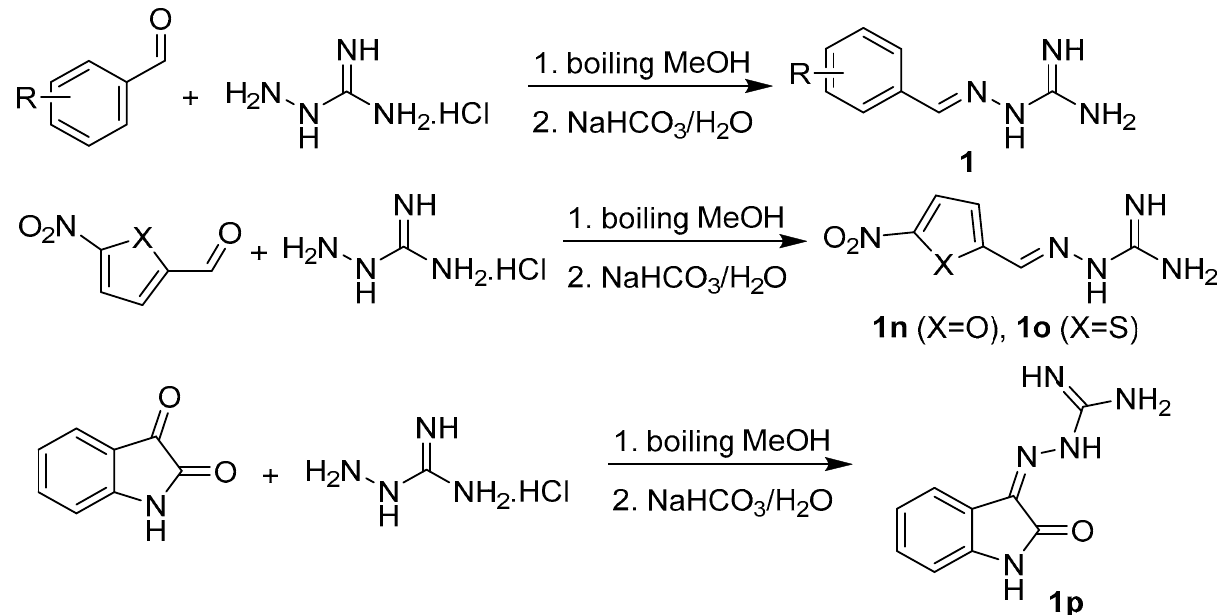
Figure 4. Synthesis of initial series of benzaldehyde/salicylaldehyde/isatin/5-nitroheteroarene-2-carbaldehyde-based aminoguanidines 1 (R = H ( 1a ), 2-/3-/4-Cl ( 1b , 1c , and 1d , respectively), 2-OH-3-Cl ( 1e ), 2-OH-4-Cl ( 1f ), 2-OH-5-Cl ( 1g ), 2-OH-6-Cl ( 1h ), 2-OH-5-I ( 1i ), 3,5-Cl 2 ( 1j ), 5-Cl-3-Br ( 1k ), 5-Cl-3-I ( 1l ), 3,5-I 2 ( 1m )).